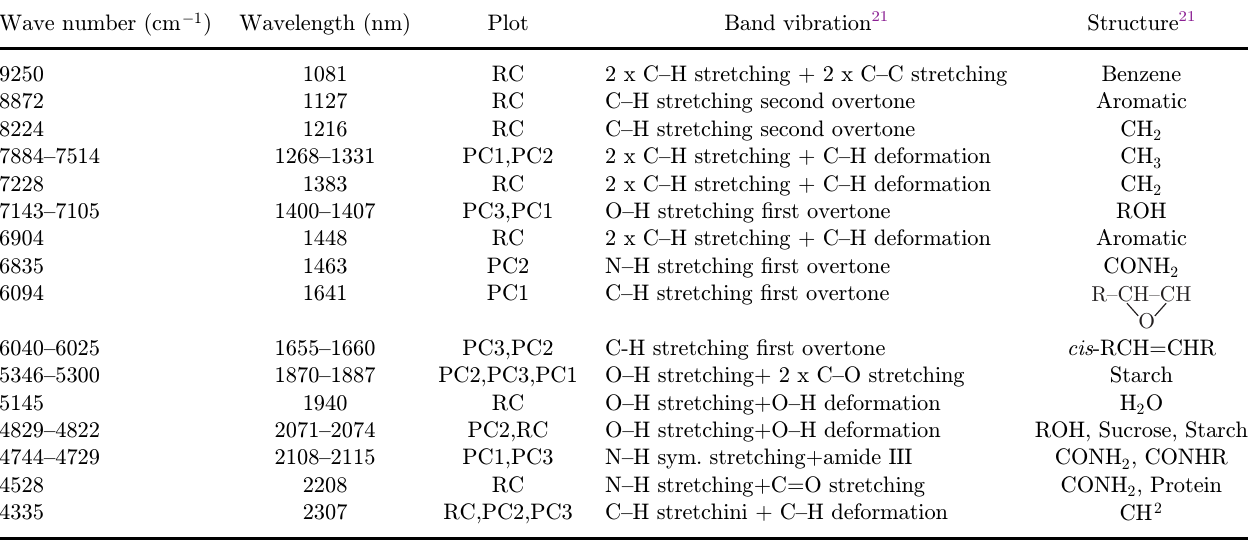
Table 3. The absorption bands (from regression coe±cient and X-loading weight) with predominantly a®ected the prediction model of DRW (%) in BHR using partial least square